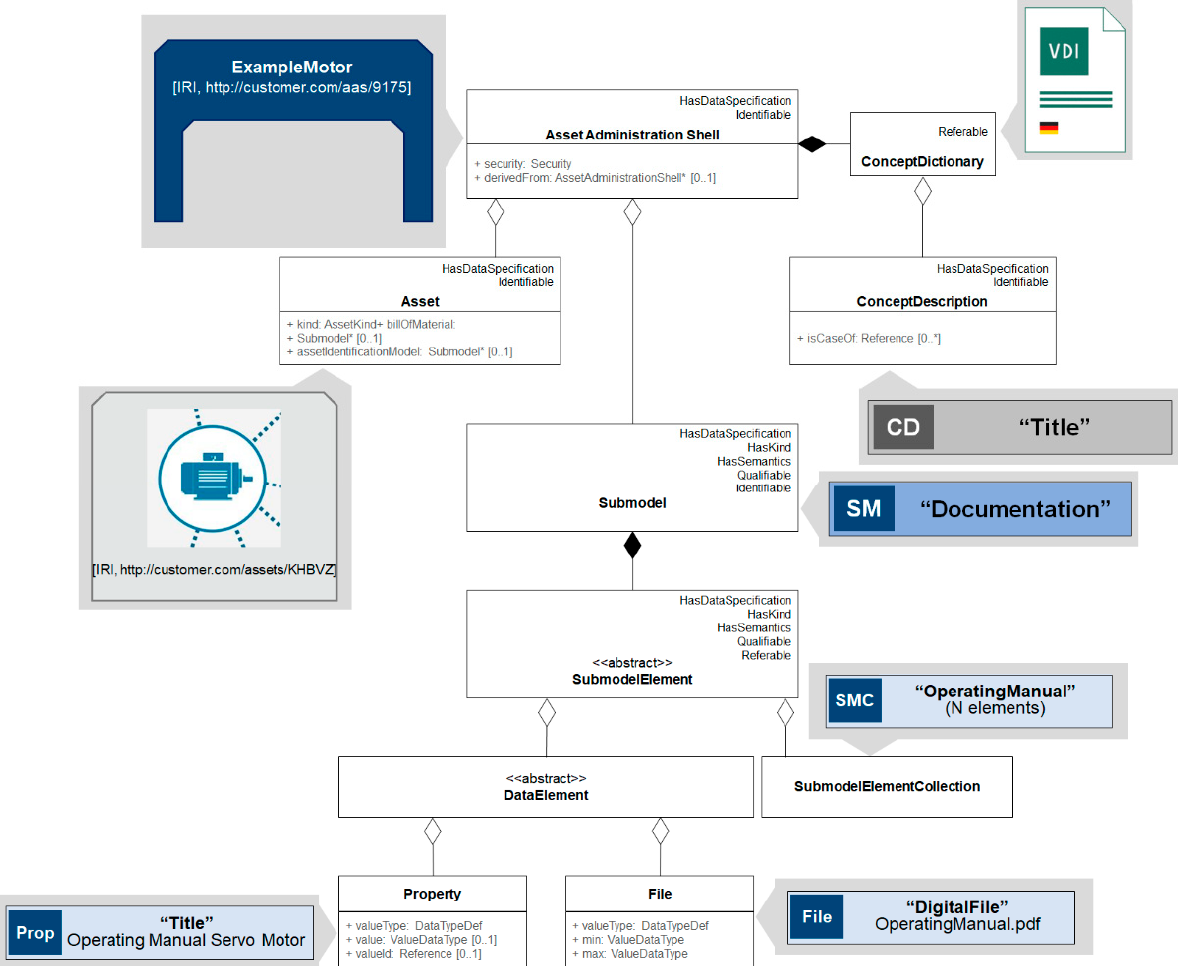
Figure 1. UML class diagram representing the metamodel of the AAS with main elements. Based on a generic servo motor as an asset, an example for the content of the AAS elements is also provided. Adapted from [34,41].